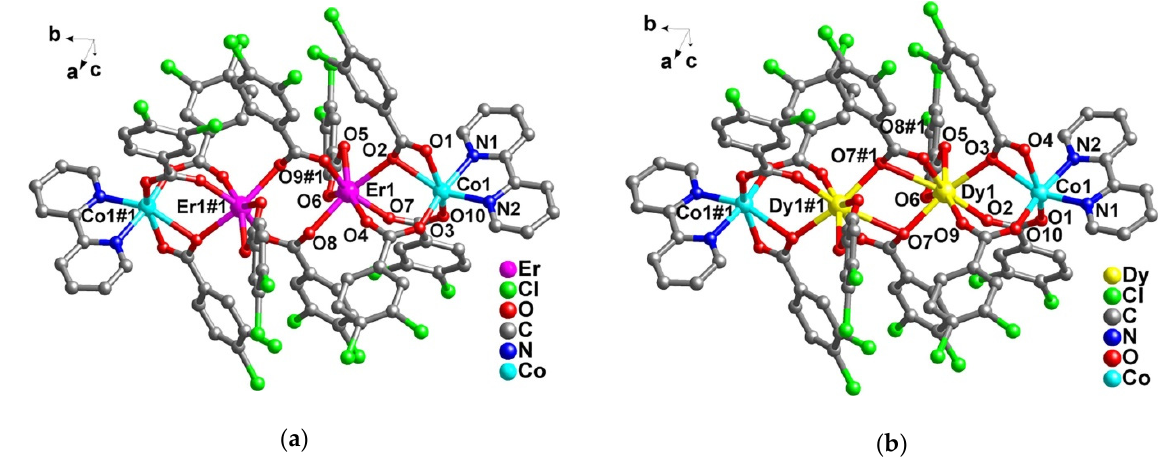
Figure 4. Molecular structures of the complexes containing ( a ) Co II 2 -Er III 2 and ( b ) Co II 2 -Ln III 2 . Hydrogen atoms are omitted for clarity. Reprinted from [82], copyright 2020, with permission from Elsevier.